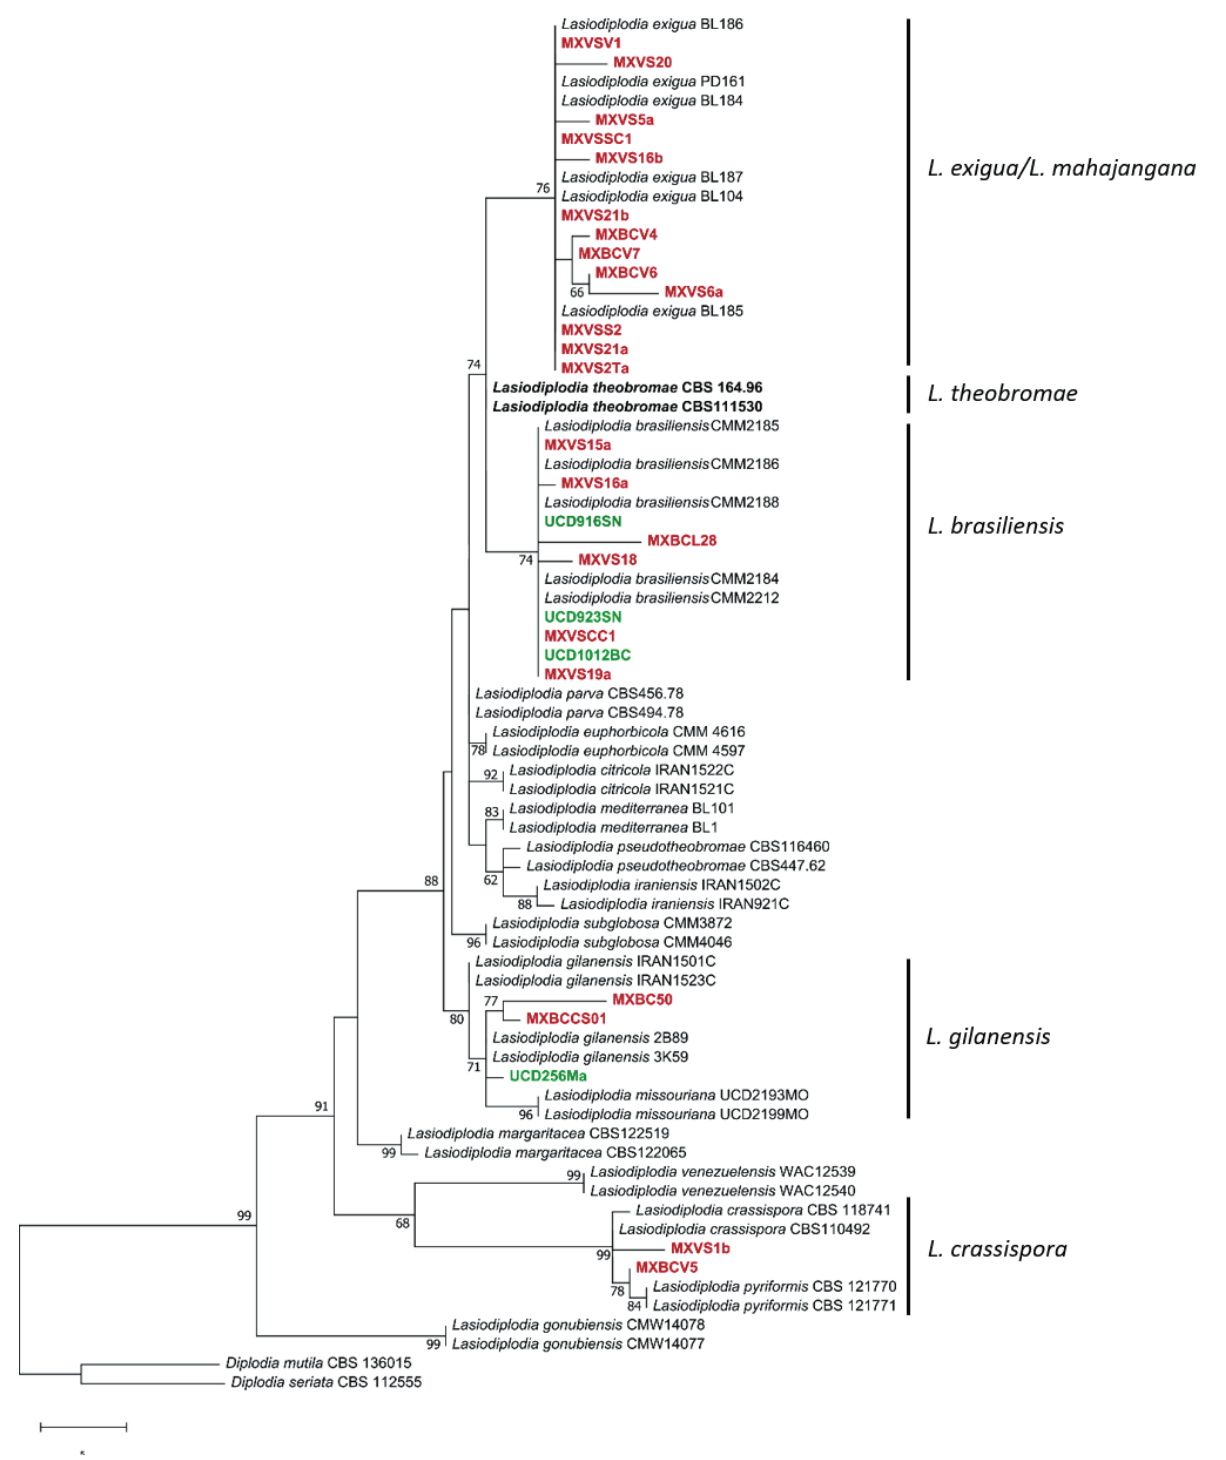
Figure 4. Phylogenetic analysis . Most-parsimonious tree (length = 151) obtained from analysis of ITS and tef1 concatenated datasets. Boot- strap values from 1000 replicates greater than 50 are indicated at the nodes. The tree is rooted with Diplodia mutila (CBS 136015) and Dip- lodia seriata (CBS 112555). The isolates from the present study are indicated in bold red font, isolates previously identified as L. theobromae are indicated in bold green font, and the L. theobromae sensu stricto isolates are indicated in bold black